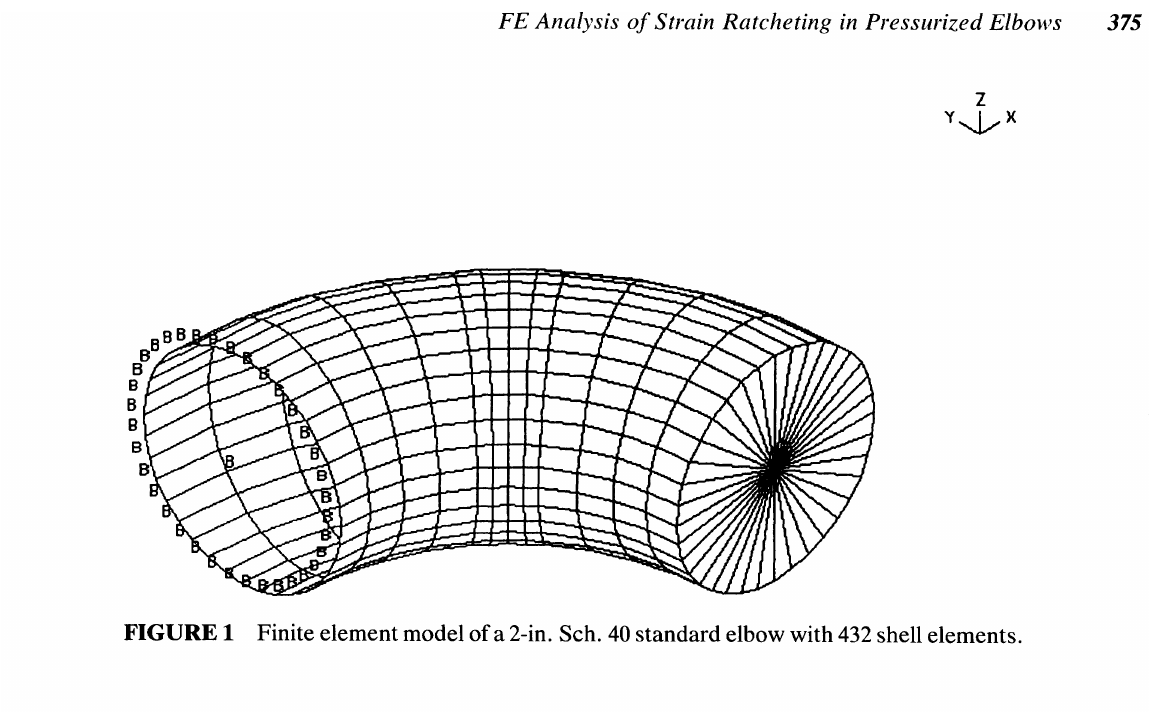
FIGURE 1 Finite element model of a 2-in. Seh. 40 standard elbow with 432 shell elements.